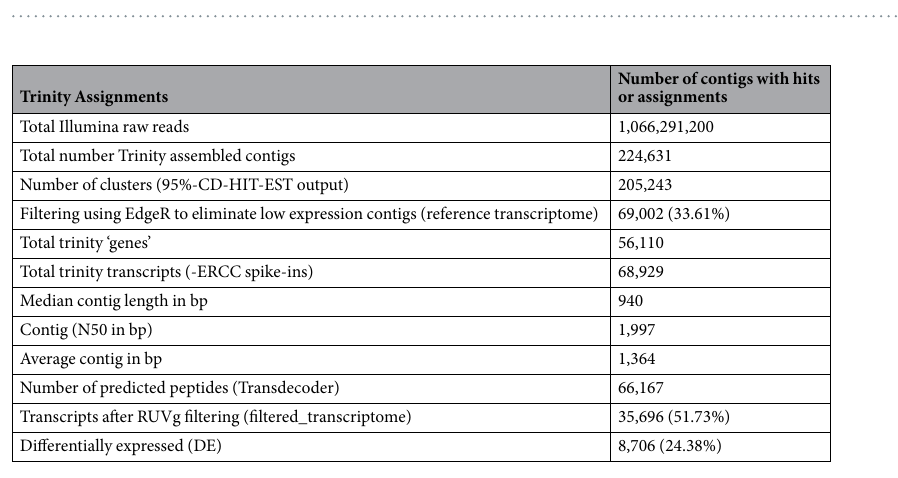
Table 2. Characterization of transcriptome assembly via